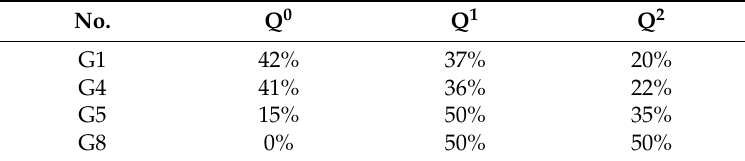
Table 5. Quantitative analysis of Q n in the unhydrated slag with di ff erent amorphous content.